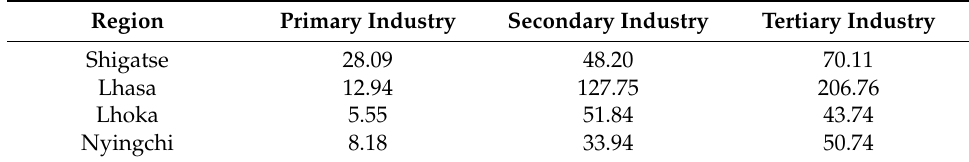
Table 1. Economic output of the studied region.